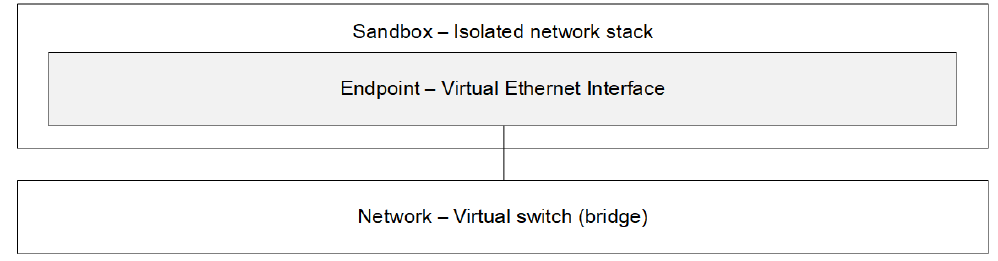
Figure 1. Overview of the container network model.